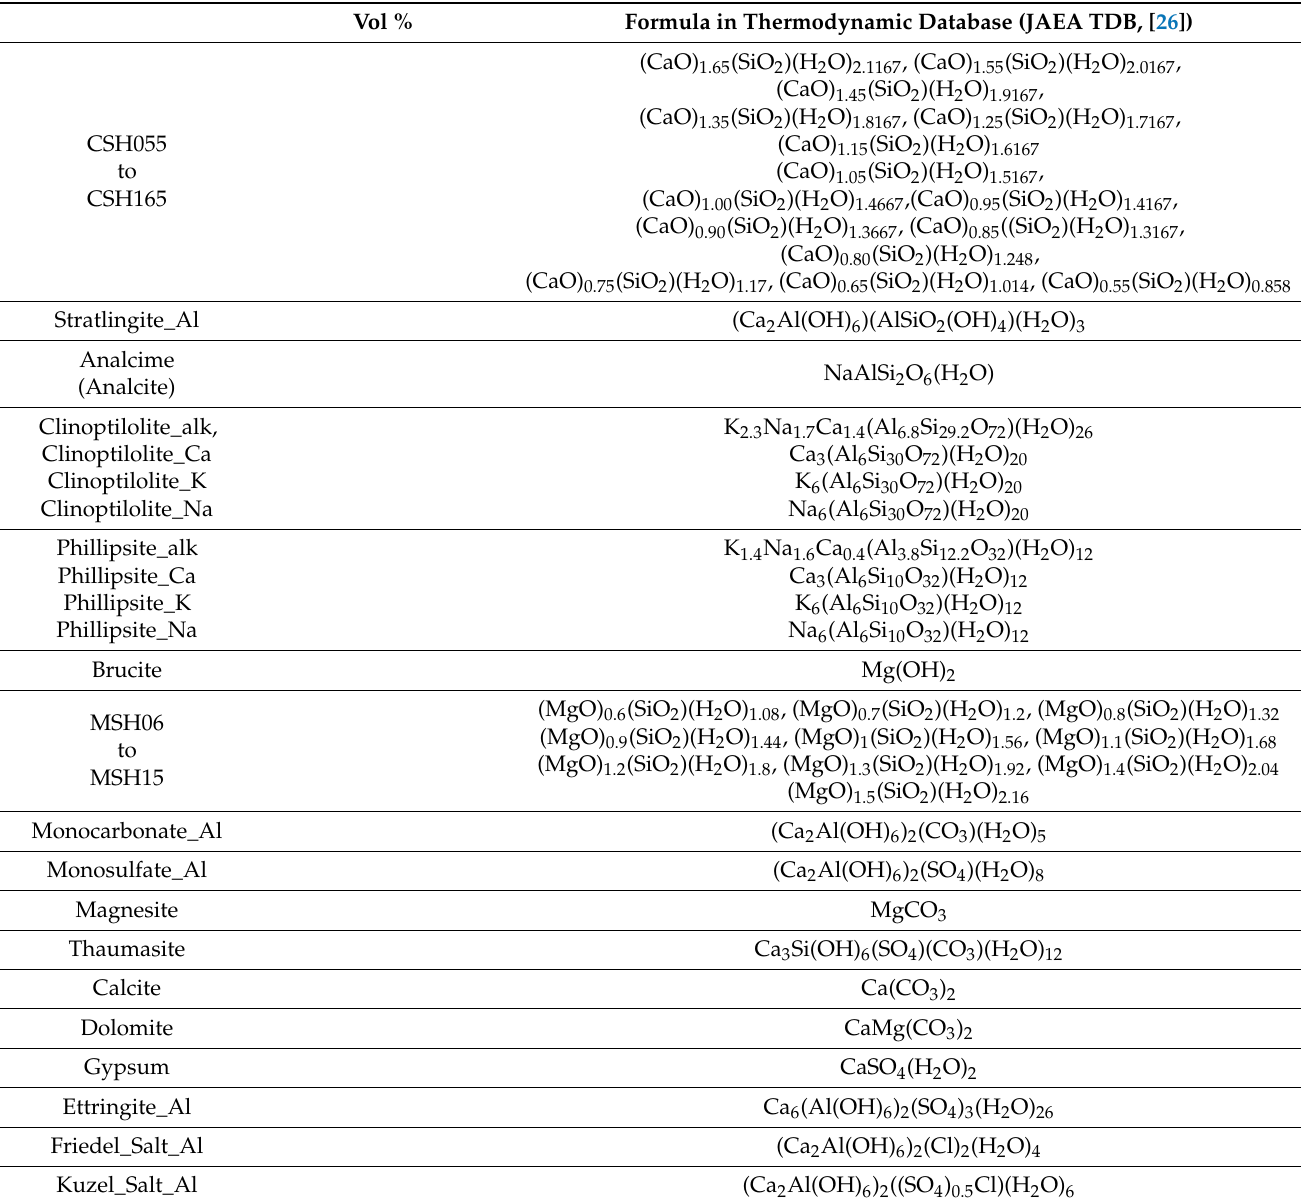
Table 2. Cont. Vol % Formula in Thermodynamic Database (JAEA TDB,